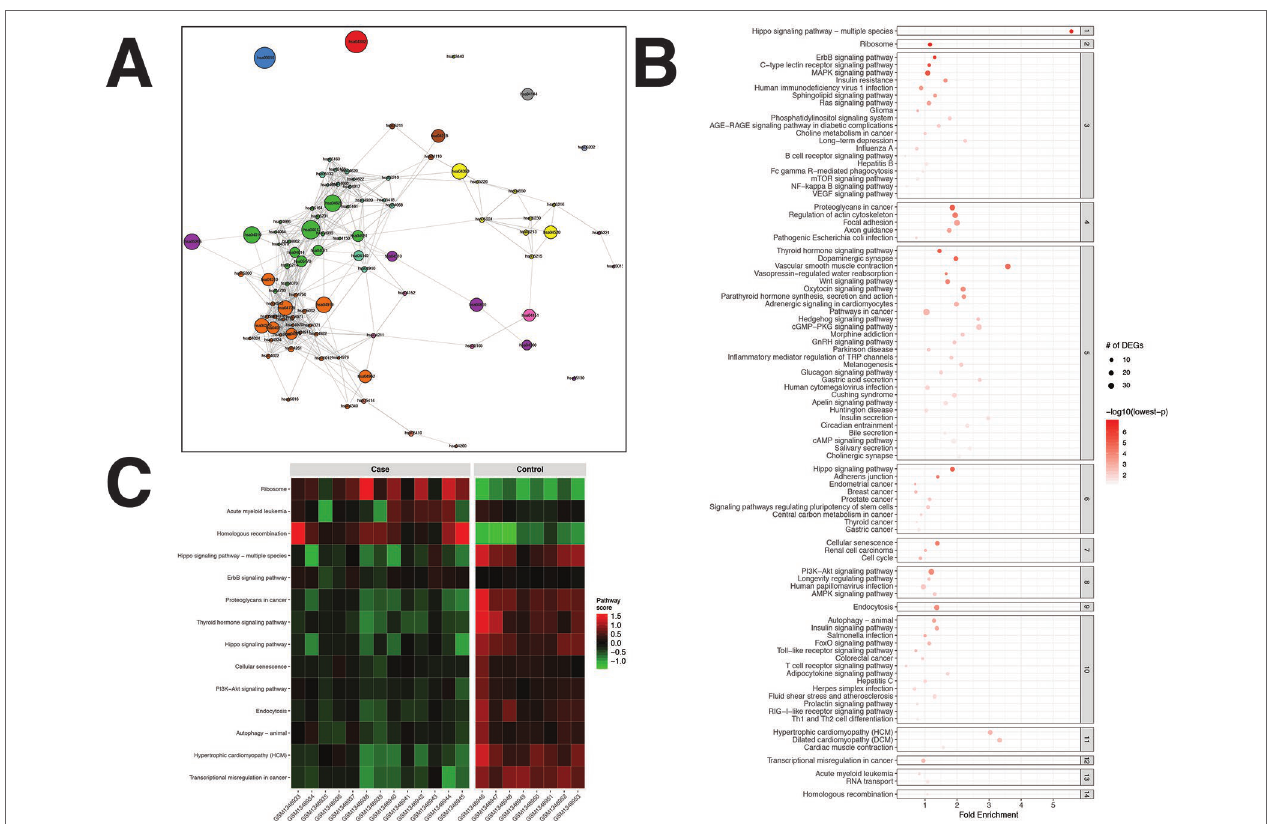
FIGURE 4 | pathfindR enrichment and clustering results on the prostate cancer (PCa) dataset (lowest p ≤ 0.05). (A) Clustering graph, each color displaying the clusters obtained for PCa. Each node is an enriched pathway. The size of a node corresponds to its −log(lowest_p). The thickness of the edges between nodes corresponds to the kappa statistic between the two terms. (B) Bubble chart of enrichment results grouped by clusters (labeled on the right-hand side of each panel). The x axis corresponds to fold enrichment values, while the y axis indicates the enriched pathways. The size of the bubble indicates the number of differentially expressed genes (DEGs) in the given pathway. The color indicates the −log10(lowest-p) value; the more it shifts to red, the more significantly the pathway is enriched. (C) Heat map of pathway scores per subject. The x axis indicates subjects, whereas the y axis indicates representative pathways. Color scale for the pathway score is provided in the right-hand